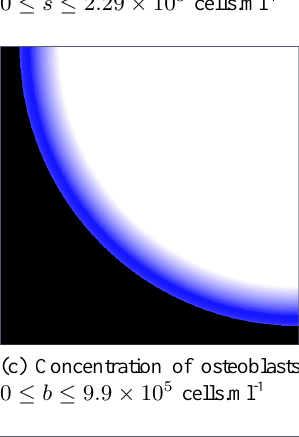
Fig. 2: Full geometry of the fracture.